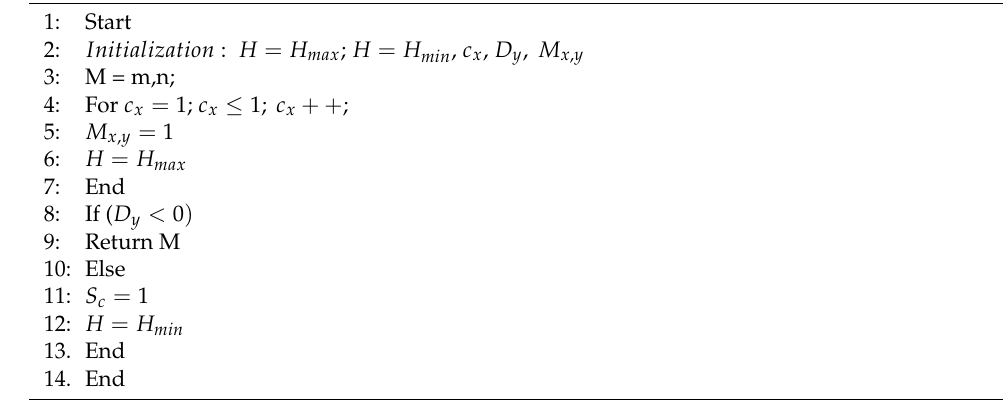
Algorithm 1: The optimization algorithm for finding the best